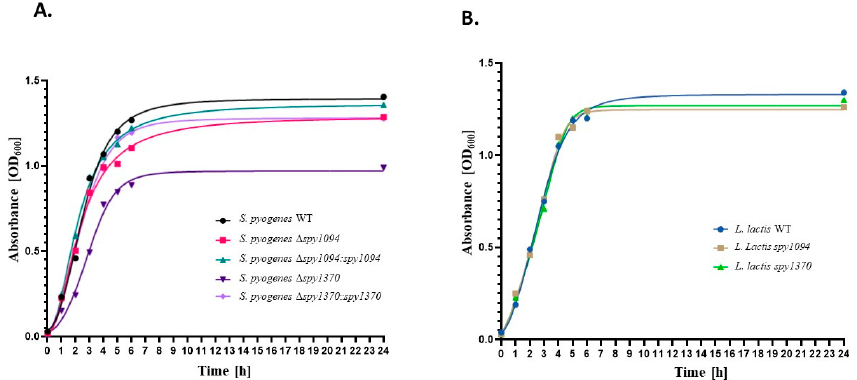
Figure 2. In-vitro growth kinetics of wildtype and mutant strains. Overnight cultures of wildtype and mutant strains were adjusted to an OD 600 of 0.04 and grown for 24 h at 37 °C. ( A ) S. pyogenes strains. ( B ) L. lactis strains.